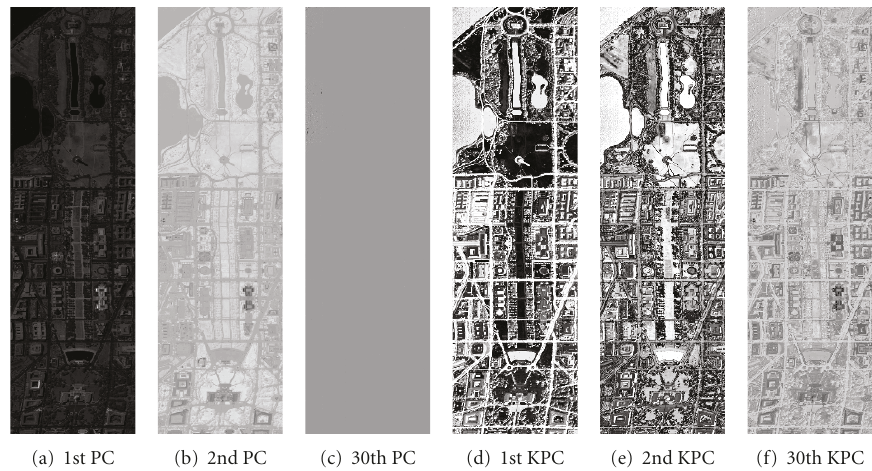
Figure 6: (Kernel) Principal component for the Washington DC data